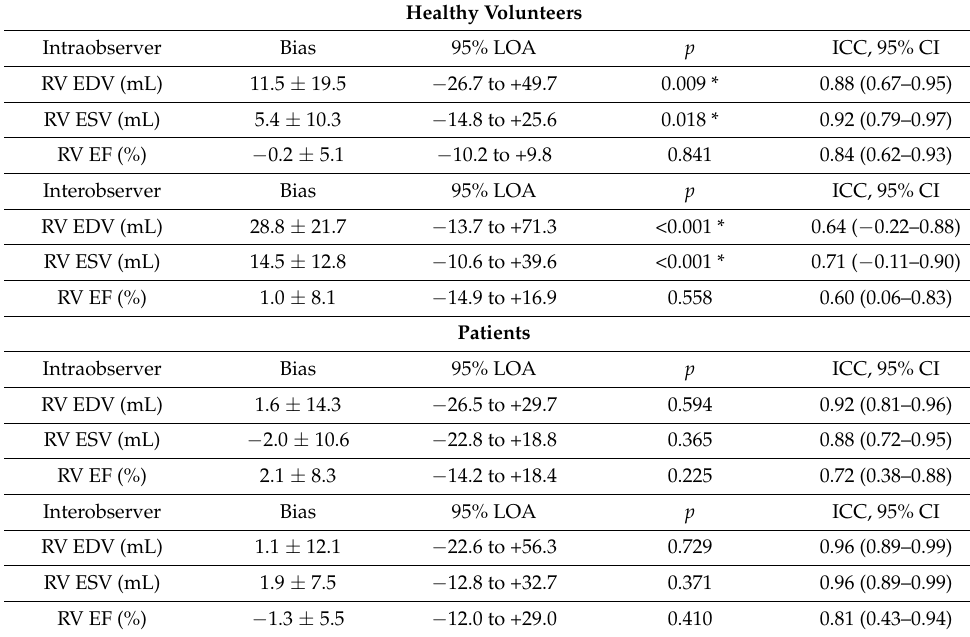
Table 4. Results of the reproducibility study of RV parameters in 3DE multi-beat